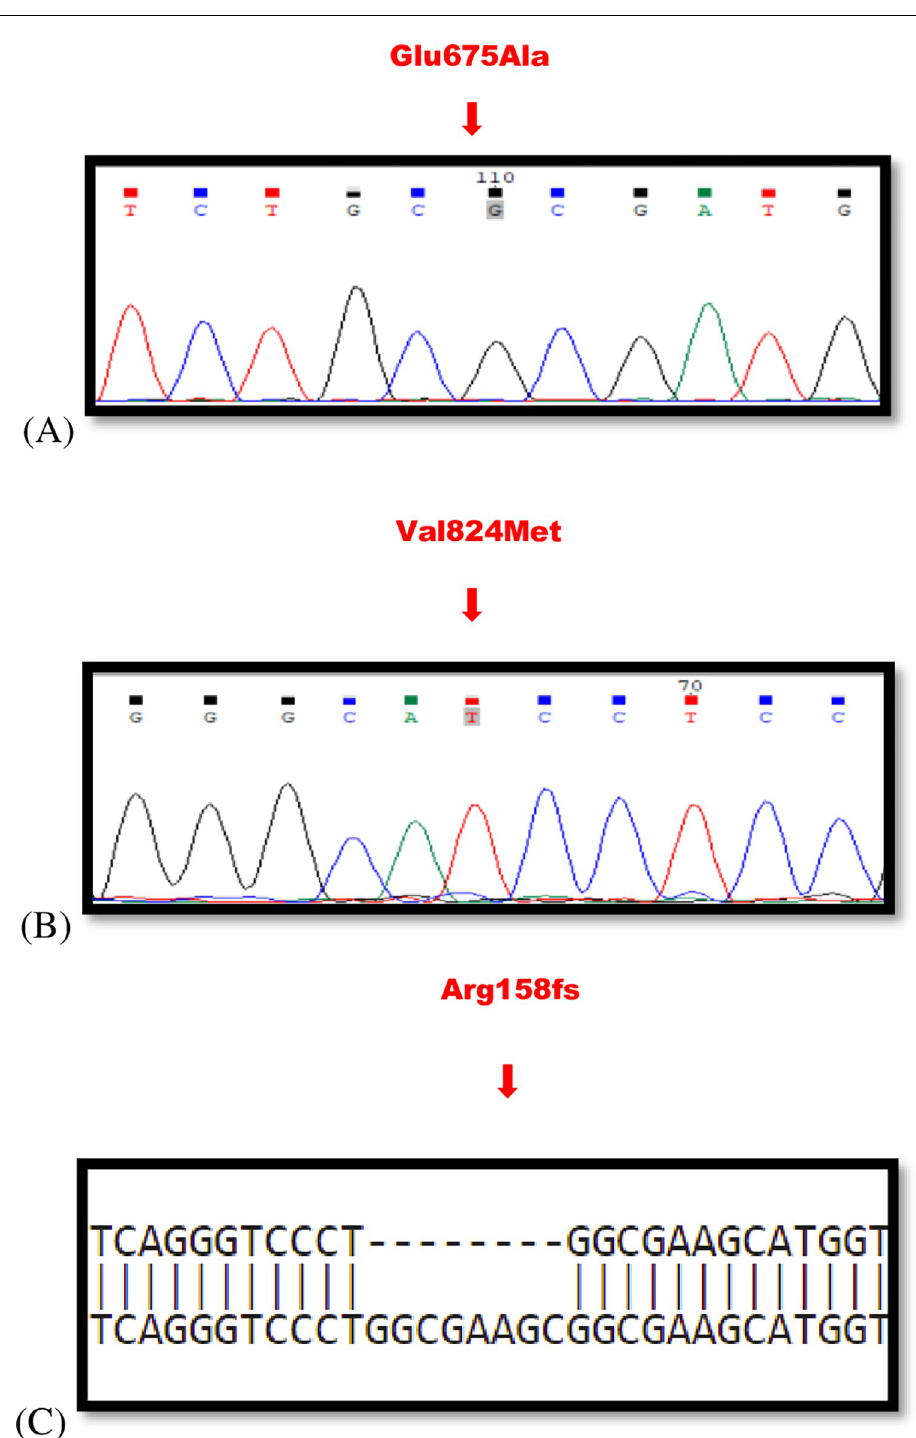
Fig 2. Mutations in the nucleotide sequence of SLC4A11 gene producing CHED phenotype. (A) Substitution of T > G in the nucleotide sequence of SLC4A11 gene producing CHED phenotype. The chromatograms of the patients are shown from families PKCD-AI01, PKCD-AI02, PKCD-AI04, PKCD-AI06, and PKCD-AI07. An arrow signifies homozygous T > G change causing missense mutation resulting in amino acid replacement of glutamic acid at location 675 with alanine. (B) Substitution of C > T in the nucleotide sequence of SLC4A11 gene producing CHED phenotype. The chromatograms of the patients are shown from families PKCD-AI03. An arrow signifies homozygous C > T change causing missense mutation resulting in amino acid replacement of valine at location 824 with methionine. (C) Frame shift deletion in SLC4A11 gene producing CHED phenotype in family PKCD-AI09 at location Arginine 158 causing truncation of protein and addition of novel amino